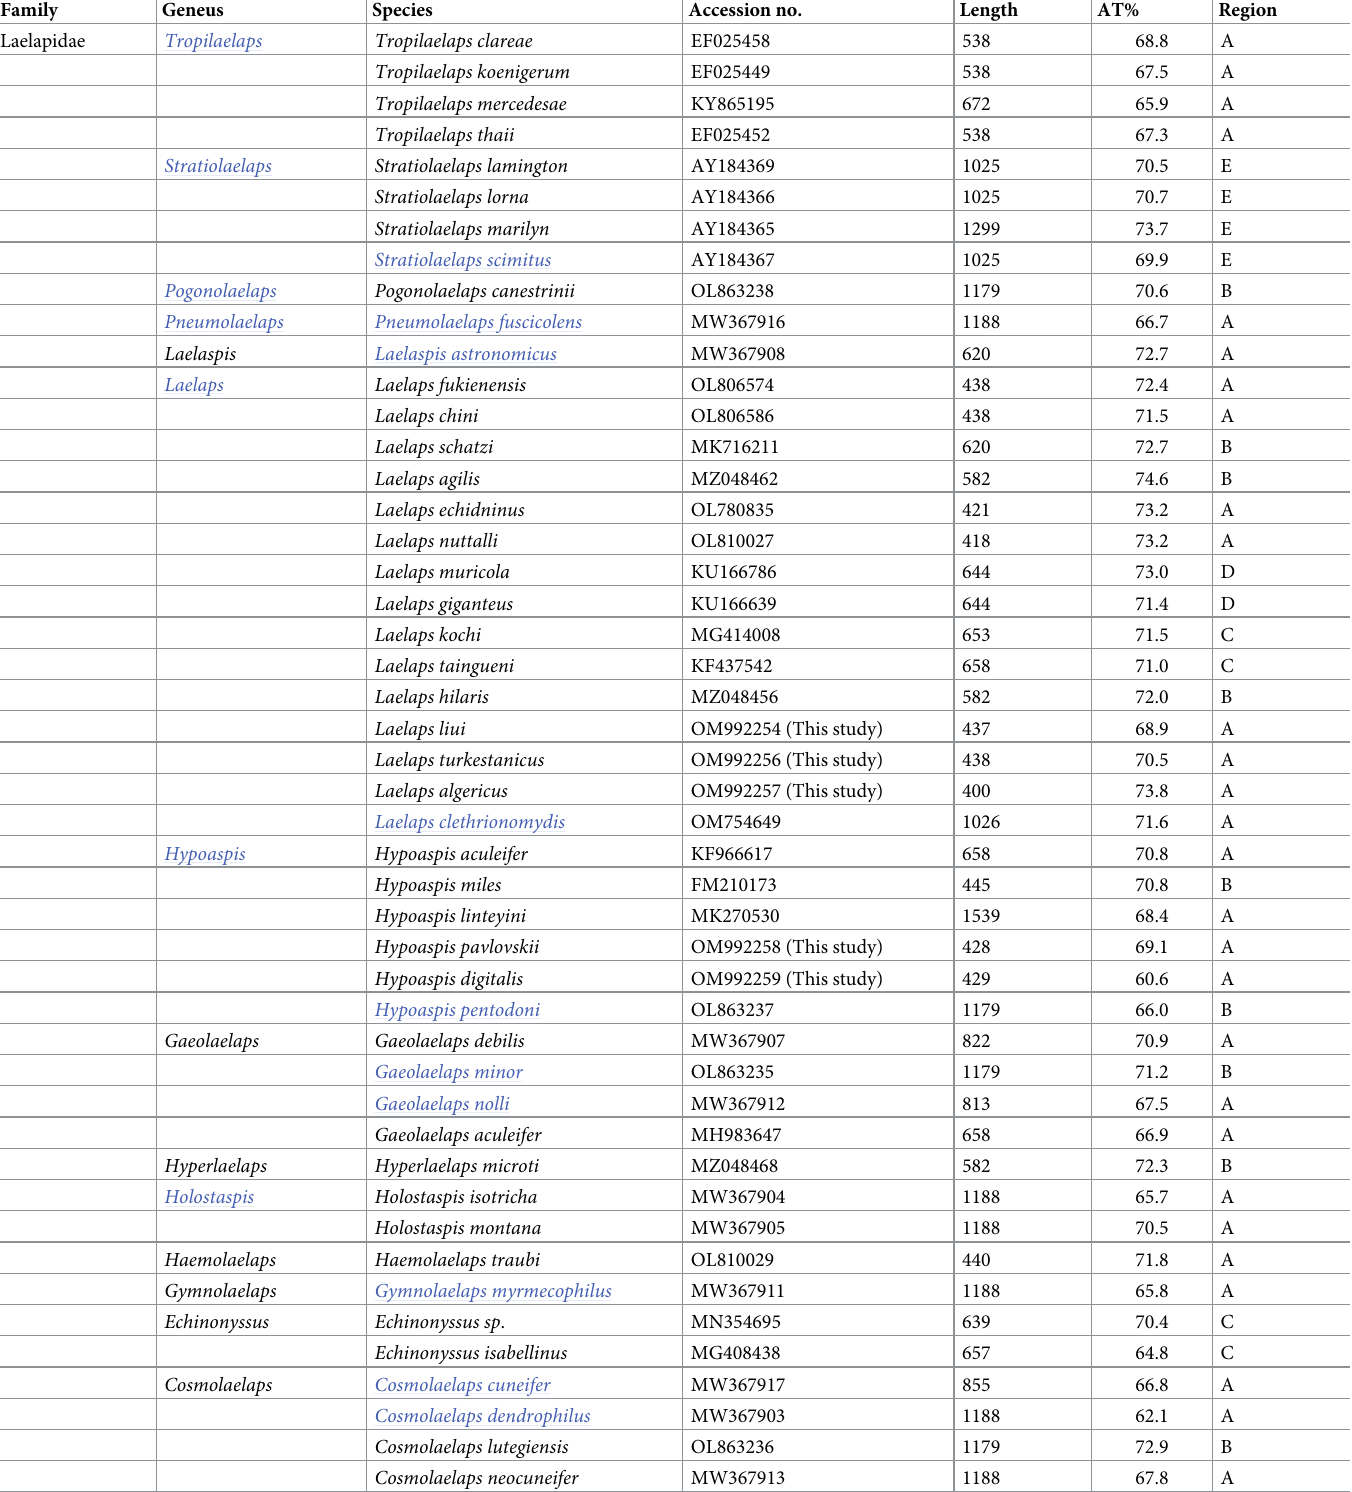
Table 1. The mitochondrial cox1 gene of the family Laelapidae used in this study. Family Geneus Species Accession no. Laelapidae